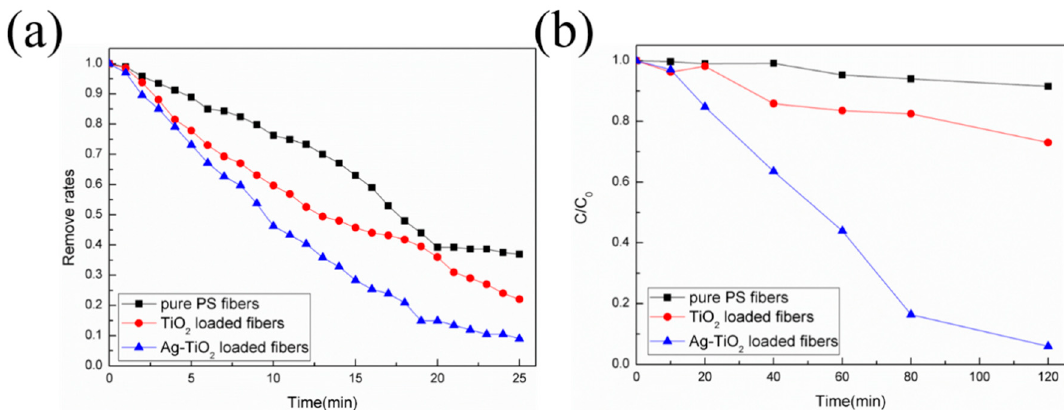
Figure 6. Characteristics of the performance of air treatment nanofibers. ( a ) The removal rates of particulate matter (PM) for three kinds of filters and ( b ) the efficiency of the degradation of toluene in such filters.